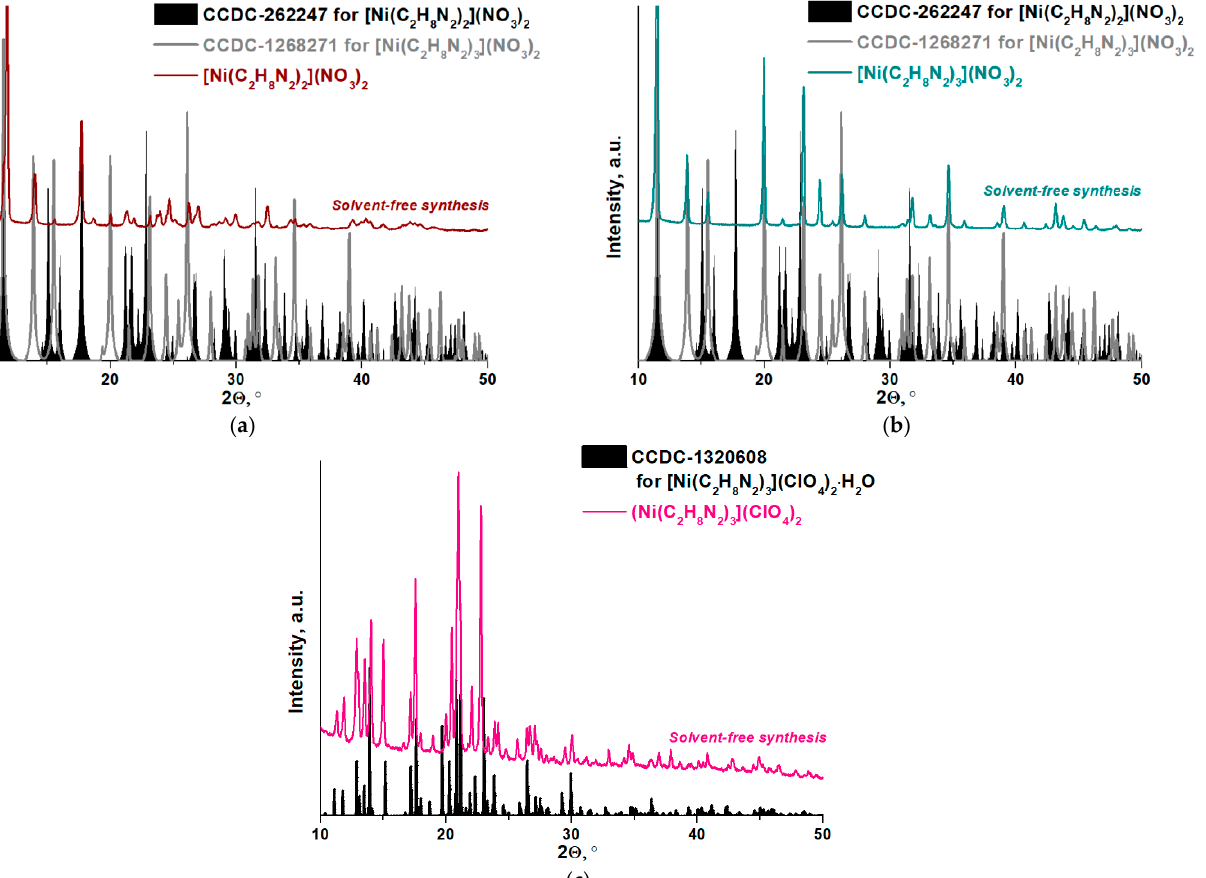
Figure 4. The power XRD data obtained for ( a ) [Ni(C 2 H 8 N 2 ) 2 ](NO 3 ) 2 , ( b ) [Ni(C 2 H 8 N 2 ) 3 ](NO 3 ) 2 and ( c ) [Ni(C 2 H 8 N 2 ) 3 ](ClO 4 ) 2 complexes. ( c ) [Ni(C 2 H 8 N 2 ) 3 ](ClO 4 ) 2